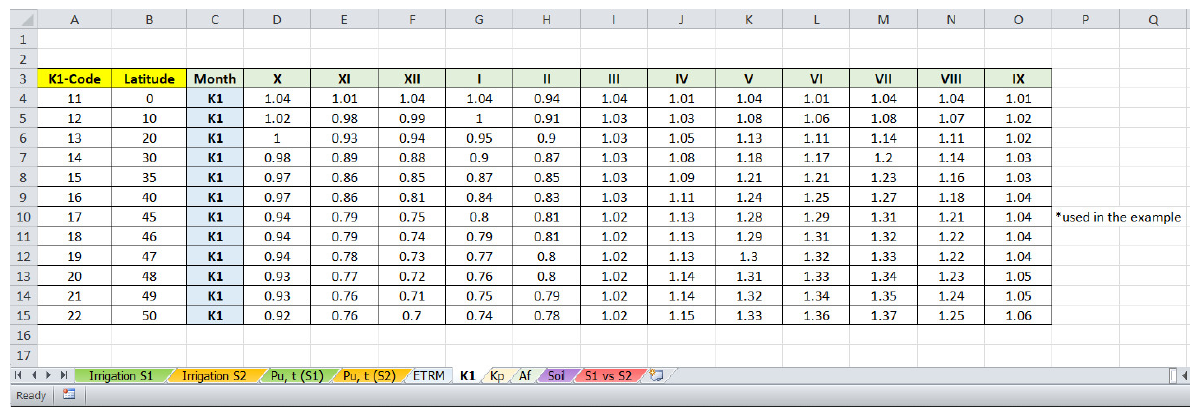
Figure 7. The “K1” worksheet. Data are taken from [34] and [47].